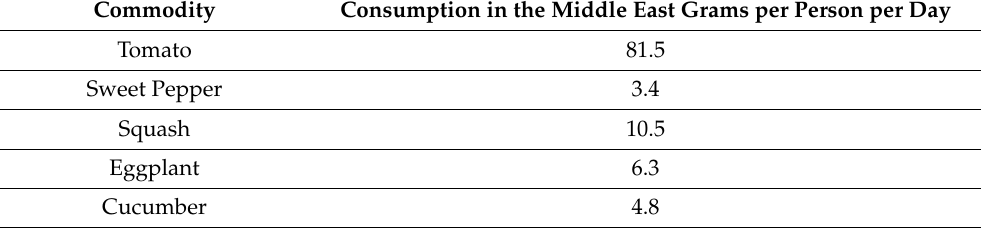
Table 2. Estimated food consumption rate (g/day) in food basket: The Global Environment Monitor- ing System/Food Contamination Monitoring and Assessment Program